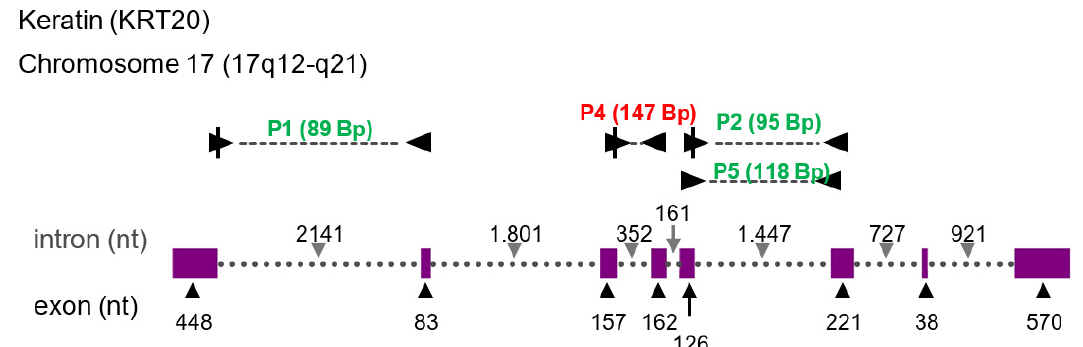
Figure 5. Depiction of selection criteria for diagnostic amplicons for PCR-based marker detection. This example shows the transcription map of the keratin (KRT20) locus. The upper panel depicts schematically the KRT20 transcript. Exons are indicated by pink bars, dashed lines indicate introns. Filled arrow heads with a vertical line indicate exon-exon spanning primers. The length of exons and introns are indicted along the transcript line. Primers and their amplicons are depicted by triangles and a dashed line in between. The amplicon length is indicated by numbers of nucleotides in green color. The amplicon indicated by red color has not full filled the criteria for specificity and/or sensitivity.